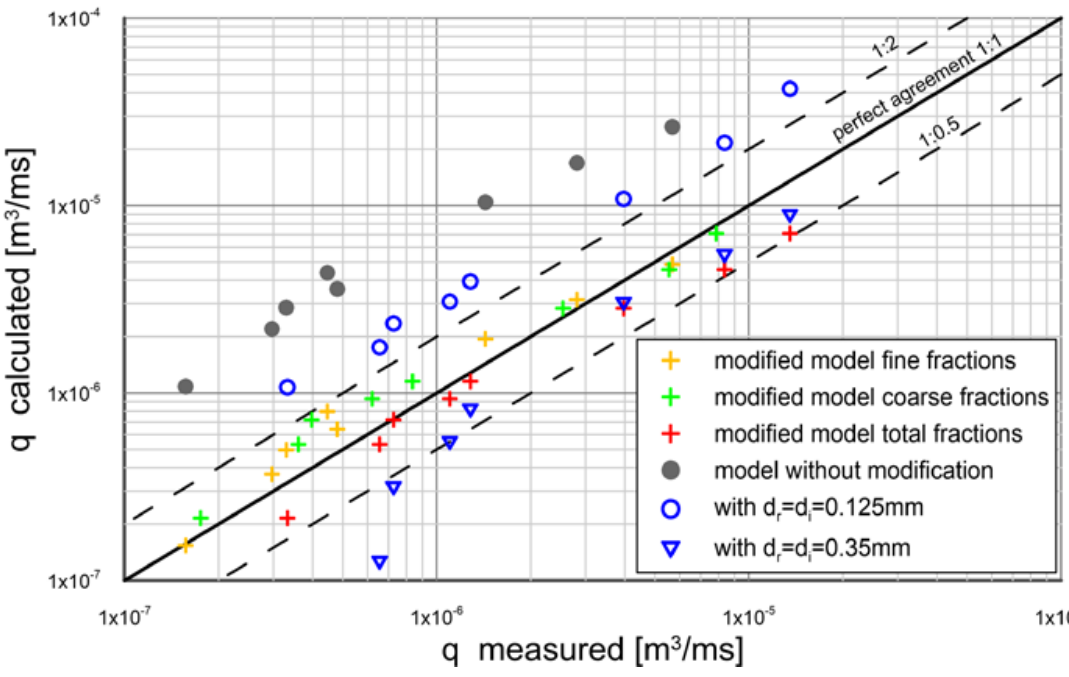
Figure 13. Comparison of sediment transport calculations with modification due to very fine fraction deficit, with calculations without modification, and with calculations for uniform sediments ( d r = d i = 0.125 mm and d r = d i = 0.35